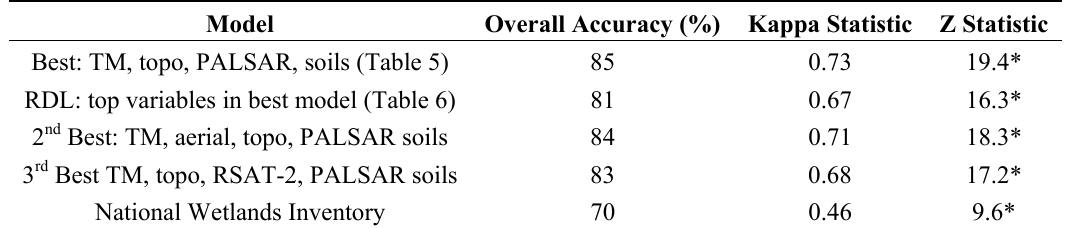
Table 7. Error matrix summary of the three best full season random forest models for the Level 1 land cover classification, as compared to the